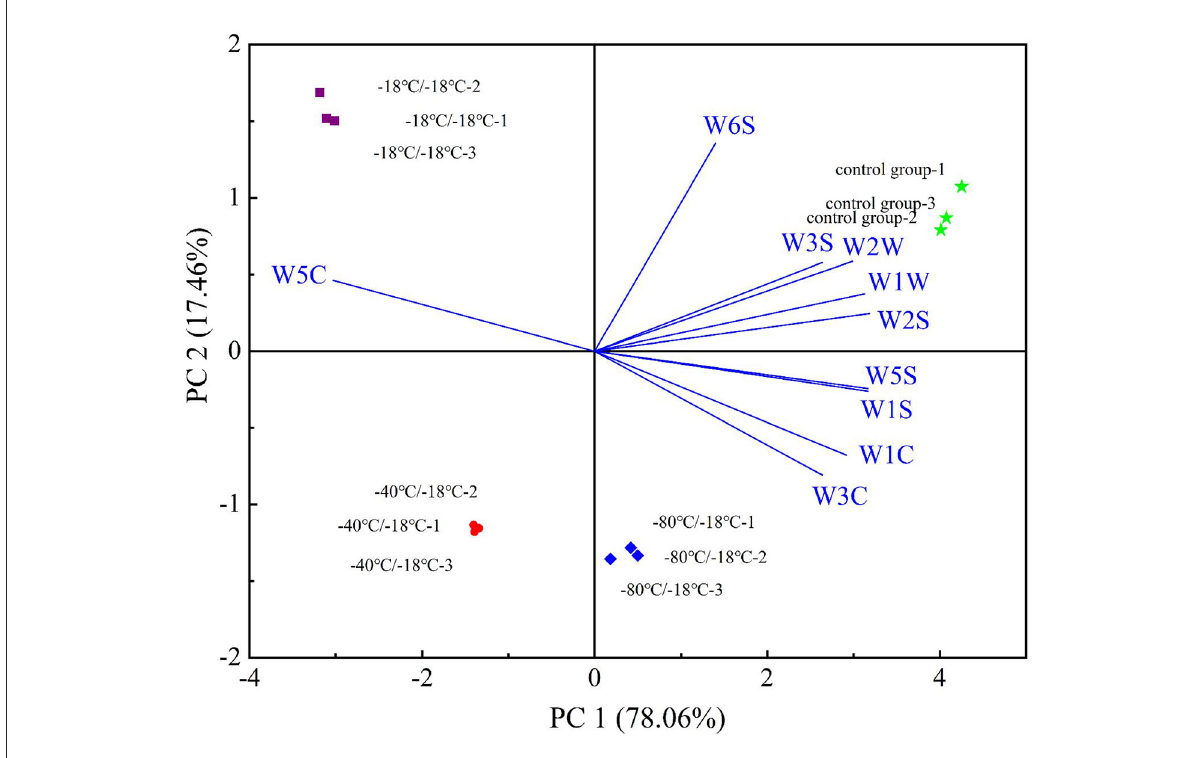
FIGURE4 PCA biplot of